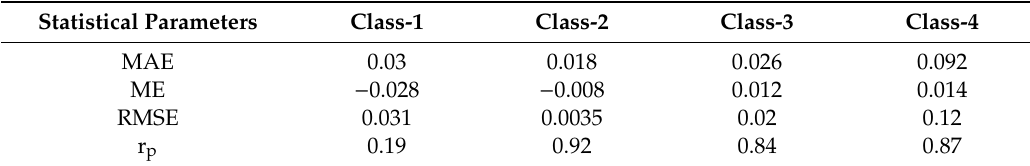
Table 3. Statistical results for the different AOD 550 nm classes that are defined for the evaluation sample. Statistical Parameters class-1 class-2